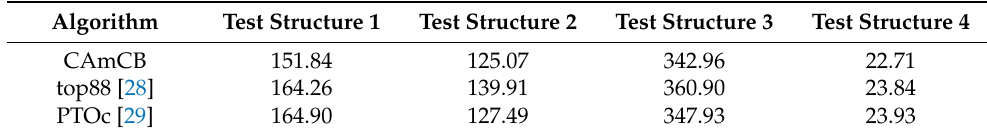
Table 1. Comparison of minimum compliance values [Nmm] found for the three algorithms.